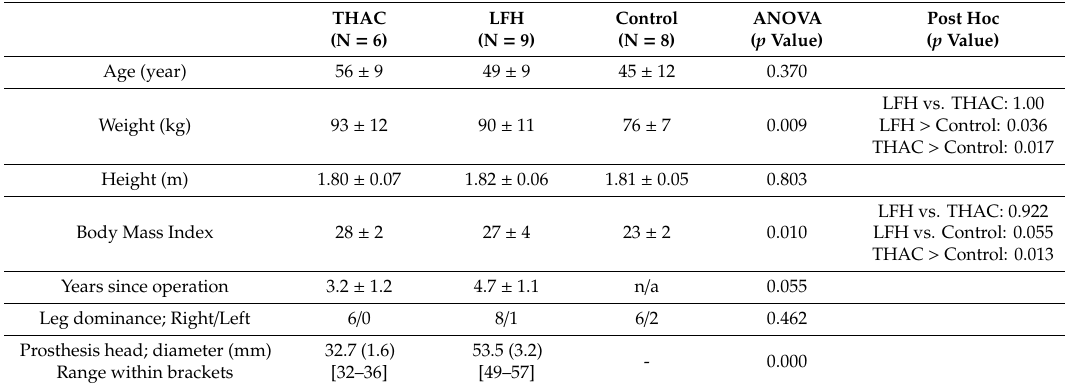
Table 1. Demographic data, years since operation and prosthesis head size given as mean ± standard deviation within parentheses for the conventional total hip replacement group (THAC), the large femoral head (LFH) design group and the control group (CTRL). Post hoc tests were performed if the analysis of variance (ANOVA) gave a significant group di ff erence and are displayed as p -values in the last column. N = number of